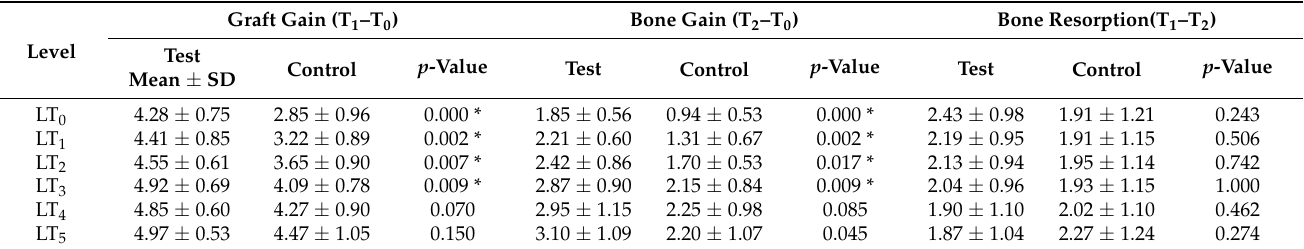
Table 3. Results of graft gain, bone gain, and bone resorption at the labial side of the virtual implant (mm).